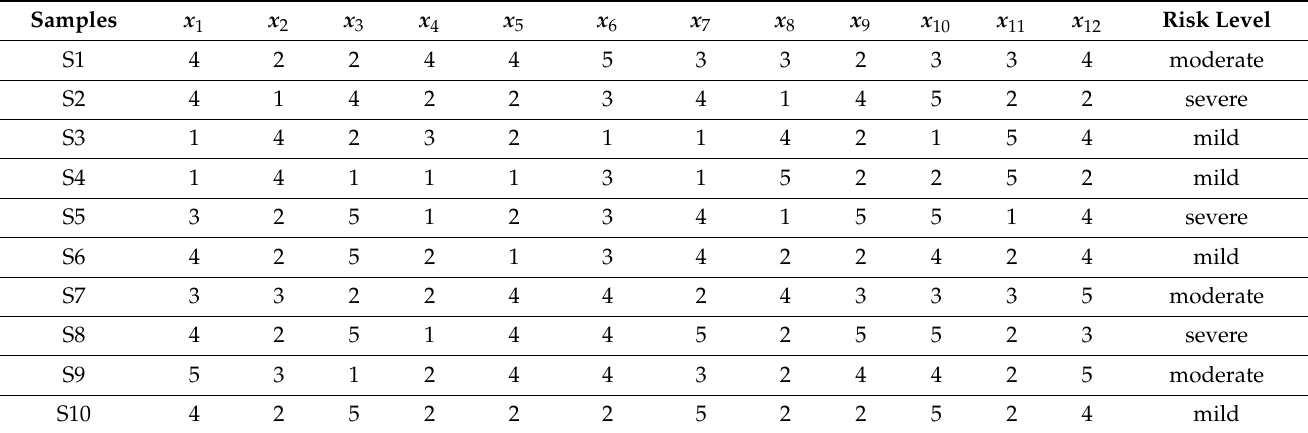
Table 1. The indicator values of the 28 samples and the corresponding risk